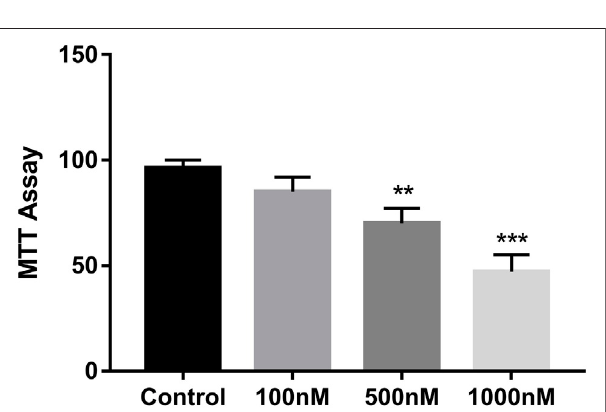
FIGURE 7 | Celastrol inhibited ovarian cancer cell proliferation. The MTT assay was used to measure cell growth. Compared with the control group, ** p < 0.01, *** p < 0.001.